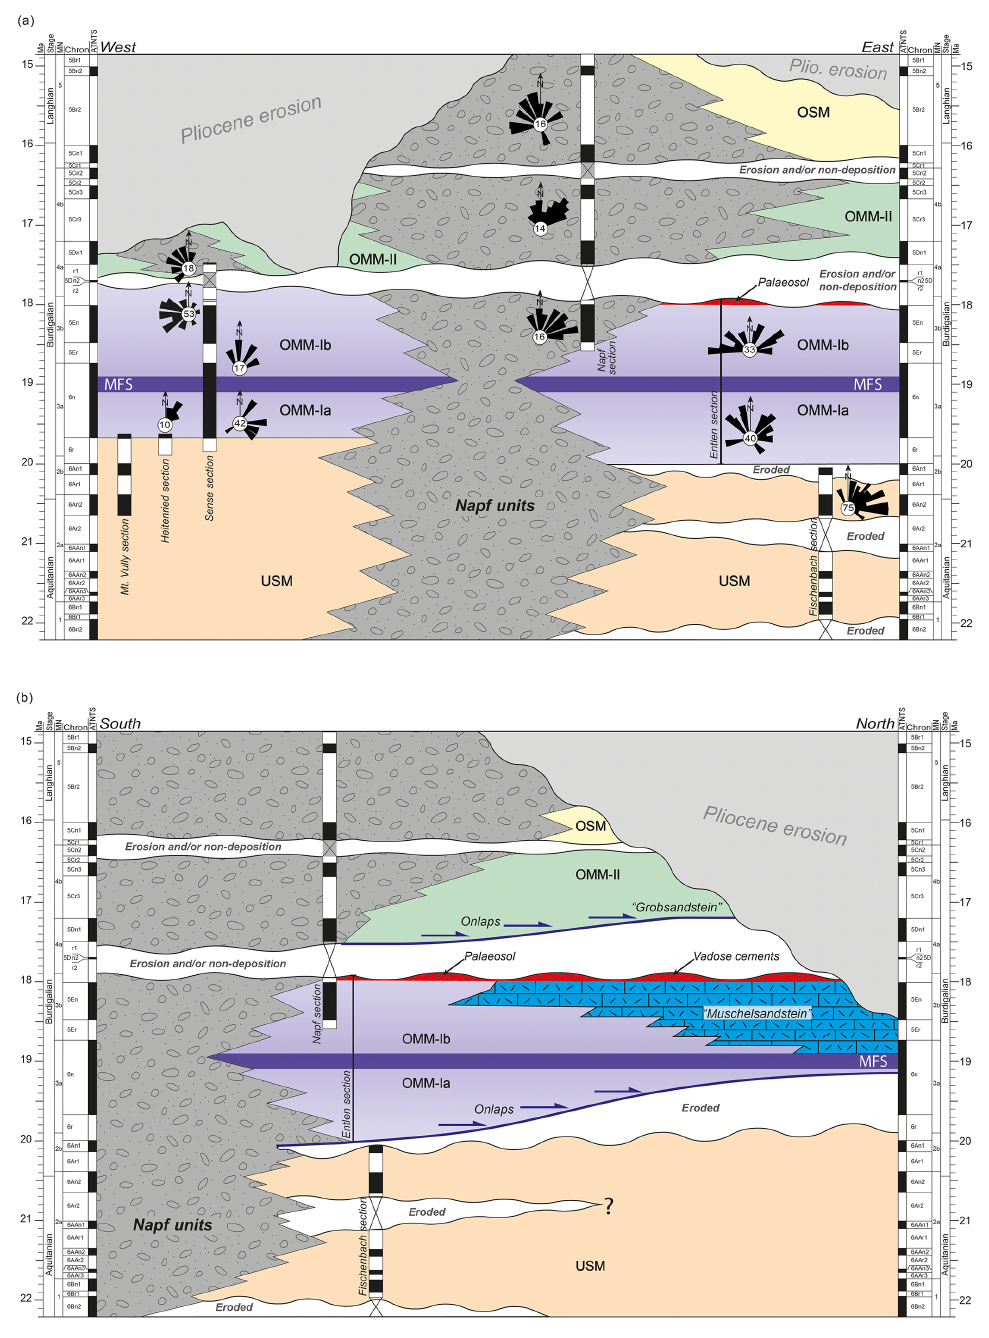
Figure 5. (a) West–east chronological (Wheeler) diagram of the Molasse sequence at the proximal basin border between Fribourg and Lucerne (Fig. 2a). The following magnetostratigraphic data have been used: Mt. Vully, Heitenried, and Sense (Strunck and Matter, 2002), as well as Napf and Fischenbach (Schlunegger et al., 1996). Palaeo-transport directions from Heitenried and the upper part of the Sense section are taken from Strunck and Matter (2002). Note that the Entlen section is not calibrated with magnetostratigraphic data but has been adjusted using regional information (see the text for further details and Fig. 3b for synthetic sections of the region). Note that Pliocene erosion removed most of the OMM-II record in western Switzerland. We infer marine conditions in the western Swiss Molasse basin during OMM-II times because (i) marine conditions were present east of the Napf units, and (ii) material transport occurred towards the west, which implies that marine conditions were also present west of the Napf megafan at that time as confirmed by mapping (e.g. Wanner et al., 2019). (b) North–south chronological (Wheeler) diagram of the Molasse sequence between Entlen (site 13) and Madiswil (site 14, both in Fig. 2a). See the text for further details. The onlaps (blue arrows) are based on interpretations from seismostratigraphic data (Schlunegger et al., 1997a). MFS: maximum flooding